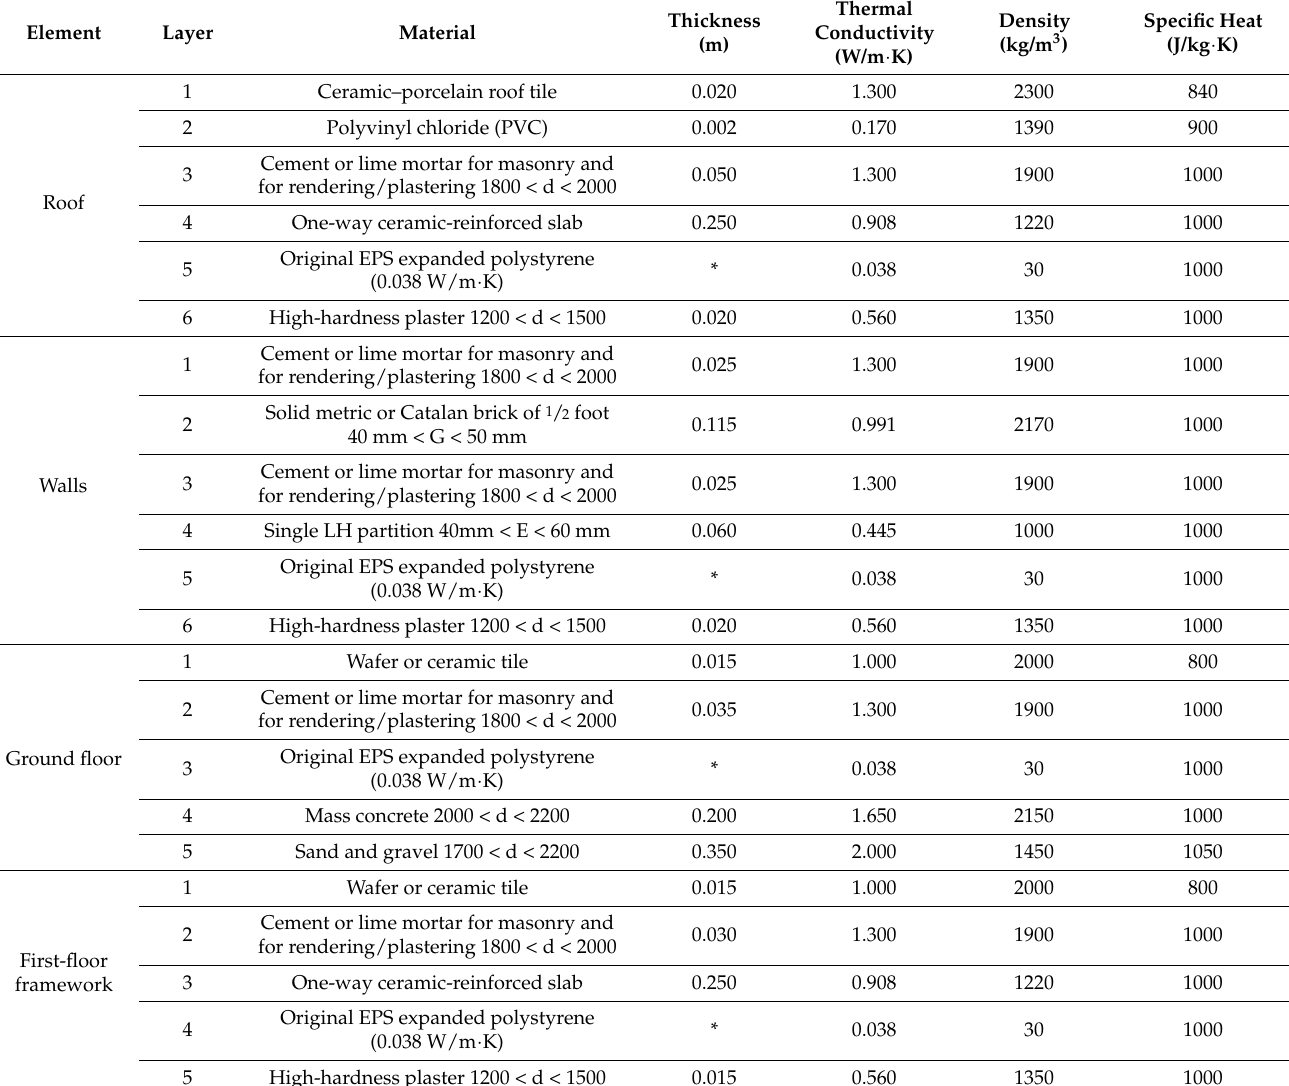
Table 3. Composition and main characteristics of the opaque elements of the thermal envelope and the interior partitions for the study building. An asterisk (*) indicates that the thickness of thermal insulation material is variable in each